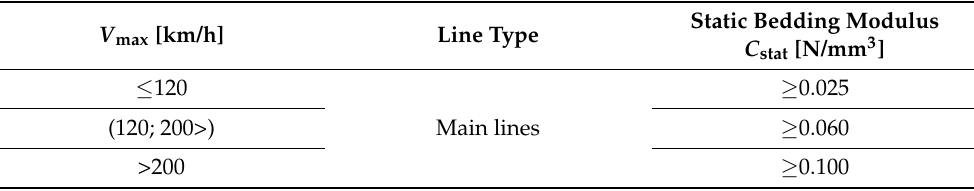
Table 3. Requirements for static bedding moduli of UBM according to ÖBB regulations [35].